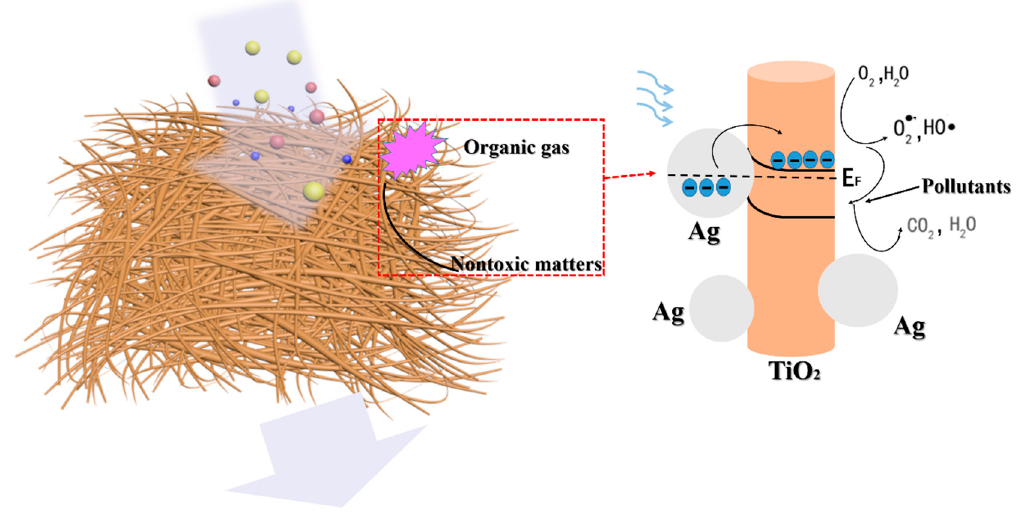
Figure 7. Mechanism for the degradation of air pollutants for the Ag-TiO 2 nanorod composite-loaded PS nanofiber filters.